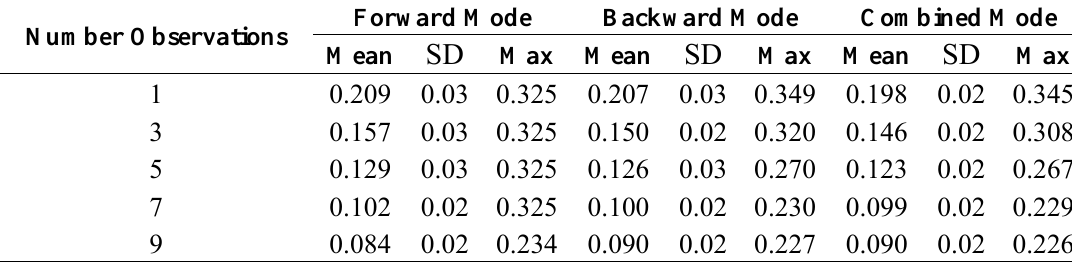
Table 6. Arizona site. Summary statistics: temporal sequence level mean normalized residuals (mean), standard deviation (SD) and maximum image-level residuals (Max) calculated from all temporal sequences generated with the same number of Landsat observations in Monte Carlo simulations. Residuals are presented for forward, backward and combined mode